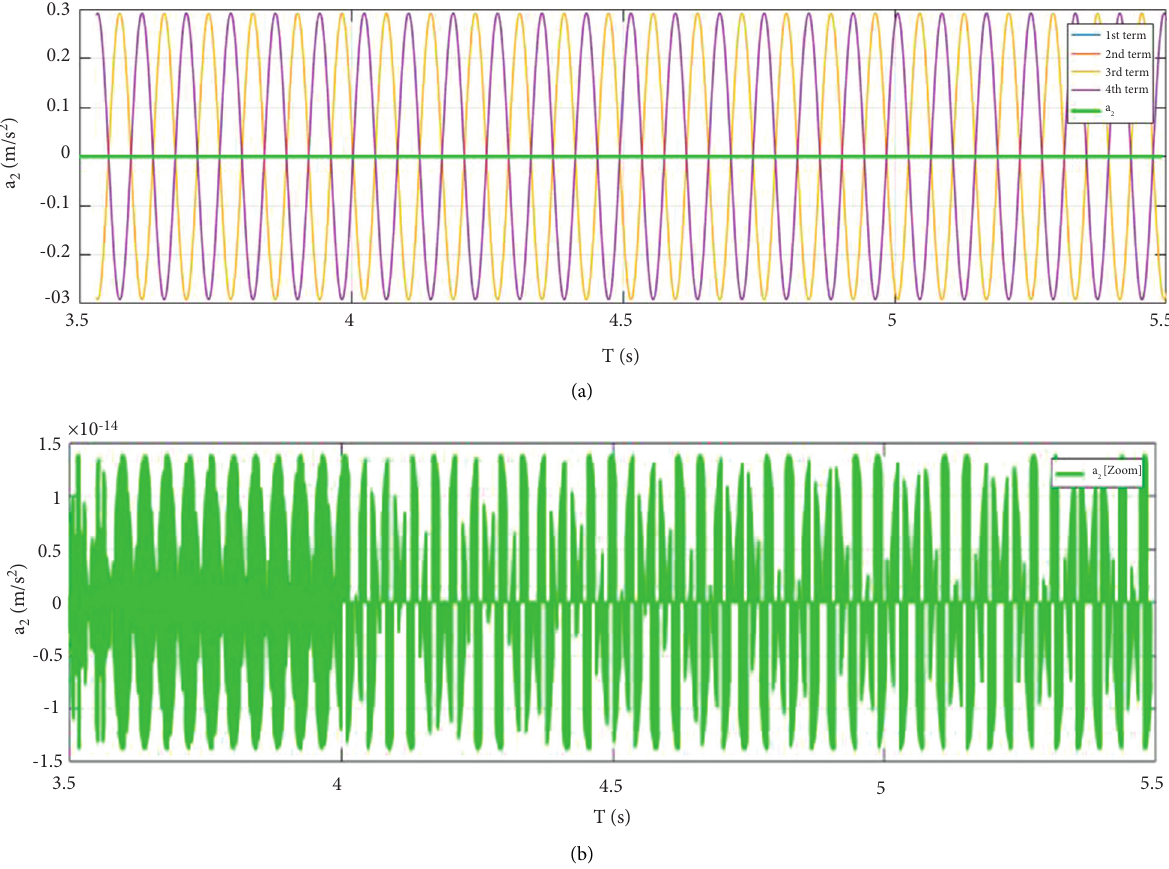
st term, orange: 2 nd